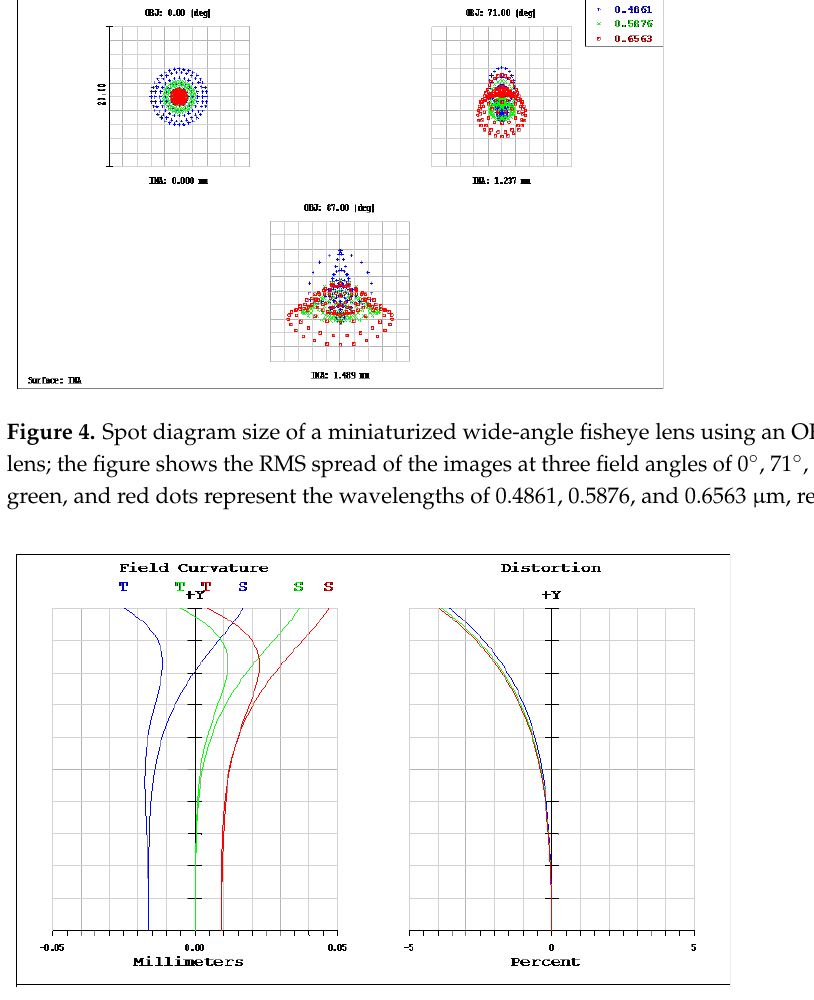
Figure 6. Lateral color of a miniaturized wide-angle fisheye lens combined with an OKP4HT aspherical lens. The blue, green, and red lines represent the wavelengths of 0.4861, 0.5876, and 0.6563 μm, respectively . Figure 7. Modulation-transfer-function (MTF) curves of a miniaturized wide-angle fisheye lens combined with an OKP4HT aspherical lens. The blue, green, and red lines represent the tangential and sagittal (T = tangential; S = sagittal) directions for the 0°, 71°, and 87° cases, respectively.